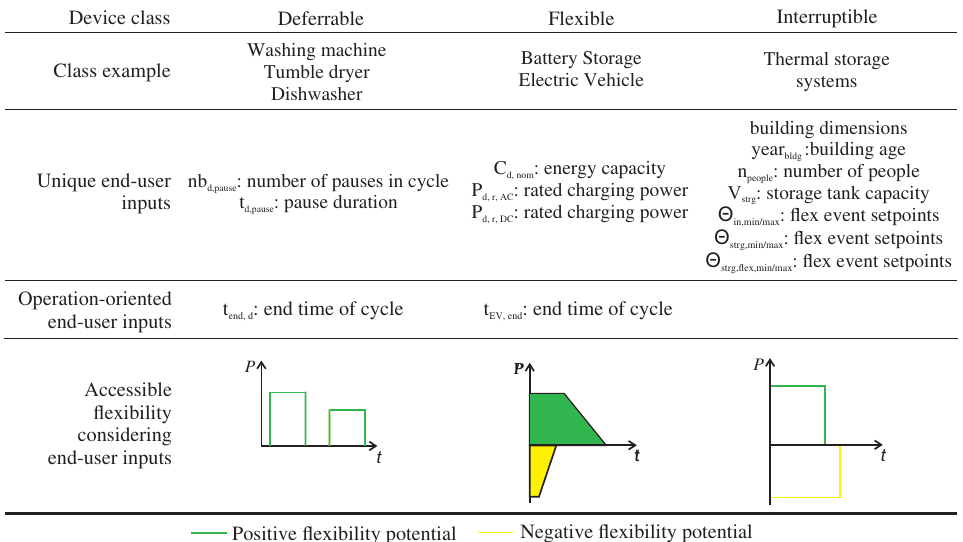
Figure 3. Device classes and associated examples of devices with Power Management System